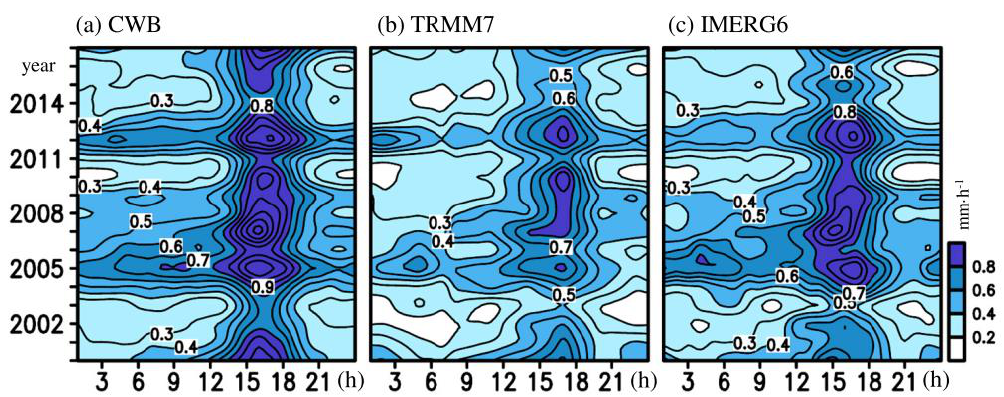
Figure 6. Temporal evolution of the hourly precipitation area-averaged over Taiwan extracted from the selected data for each specific summer during 2000–2017: ( a ) the CWB data, ( b ) TRMM7, and ( c ) IMERG6.